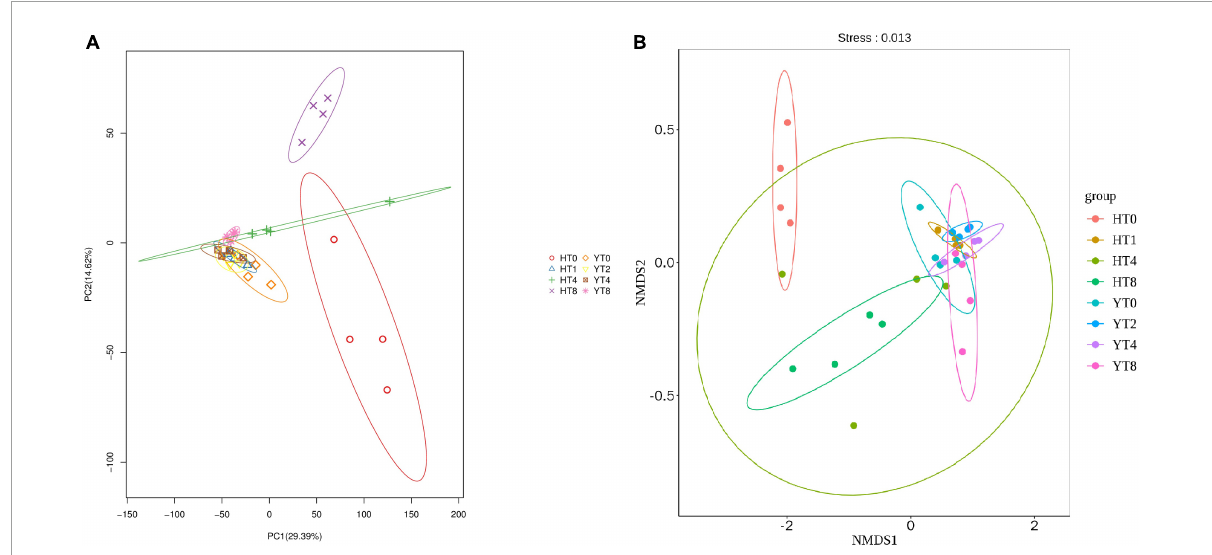
FIGURE1 Beta diversity analysis showing distribution of fungal communities among samples of both varieties Honghua Dajinyuan (H) and Yunyan 87 (Y) (A) Principal component analysis (PCA) analysis and (B) Non-Metric Multi-Dimensional Scaling (NMDS) analysis, each treatment group is colored differently and each point in figure show differences between the groups and within group samples.